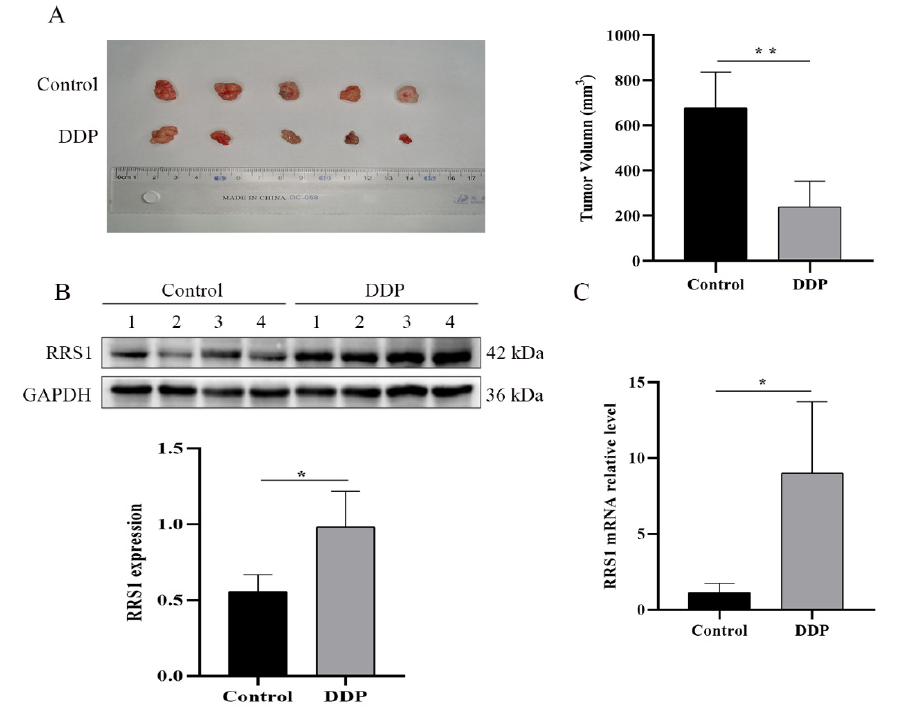
Figure 5. Cisplatin induced RRS1 overexpression in vivo. MCF-7 cells were injected into nude mice, which were injected with 15 mg/kg DDP once weekly for 4 weeks. ( A ) Representative images of tumors extracted from the indicated groups. ( B ) Immunoblot showing RRS1 protein levels in the tumor tissues of the indicated groups. ( C ) RRS1 mRNA levels in the indicated tumor groups. Data are expressed as means ± SDs of at least three independent experiments. * p < 0.05, ** p < 0.01. DDP, cisplatin.